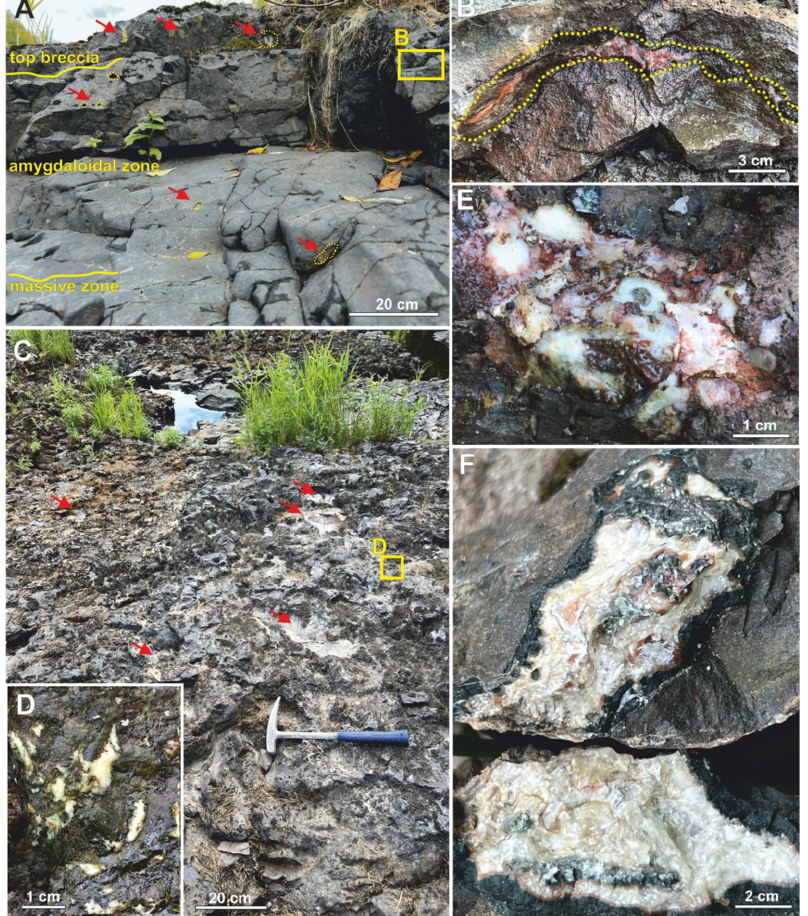
Figure 2. Field outcrop photographs illustrating agates’ location in the Mesoproterozoic volcanics within the Pasha–Ladoga Basin (Priozersk Formation). ( A ) the upper part of lava flow with the massive, amygdaloidal and breccia zones within the coastal cliffs on the Tulemajoki River; ( B ) vein agate in the inter-breccia lava space, ( C ) brecciated top of the lava flow; ( D ) enlarged fragment from selected area of ( C ) showing agates in the inter-clastic lavas space, ( E ) cavity infilling with Fe-enriched agate; ( F ) large gas vesicles within the massive lava filled with agate. Red arrows point to the location of agate mineralization within the